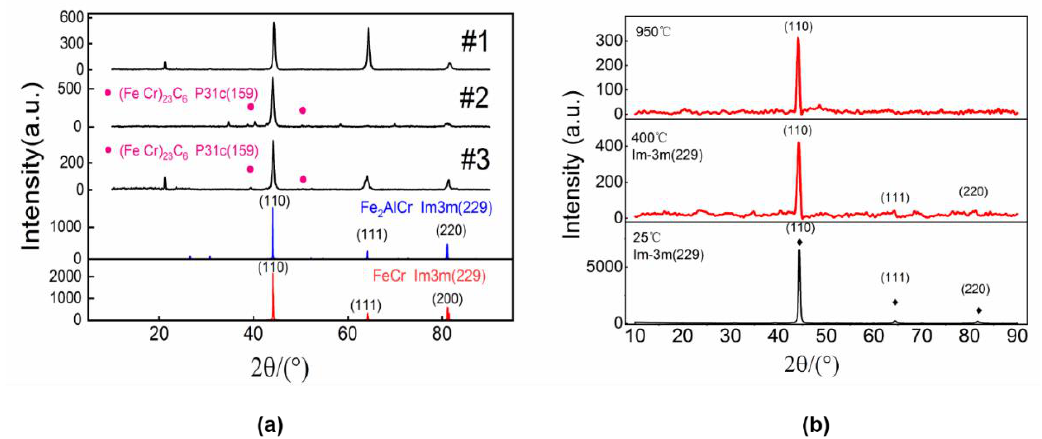
Figure 10. XRD results of the #1, #2 and #3 alloys. ( a ) Comparison of XRD images of Alloys with XRD of Standard Substances. The Fe 2 AlCr and FeCr phases were coherent and coplanar. ( b ) XRD results of #1 alloy at different temperatures.